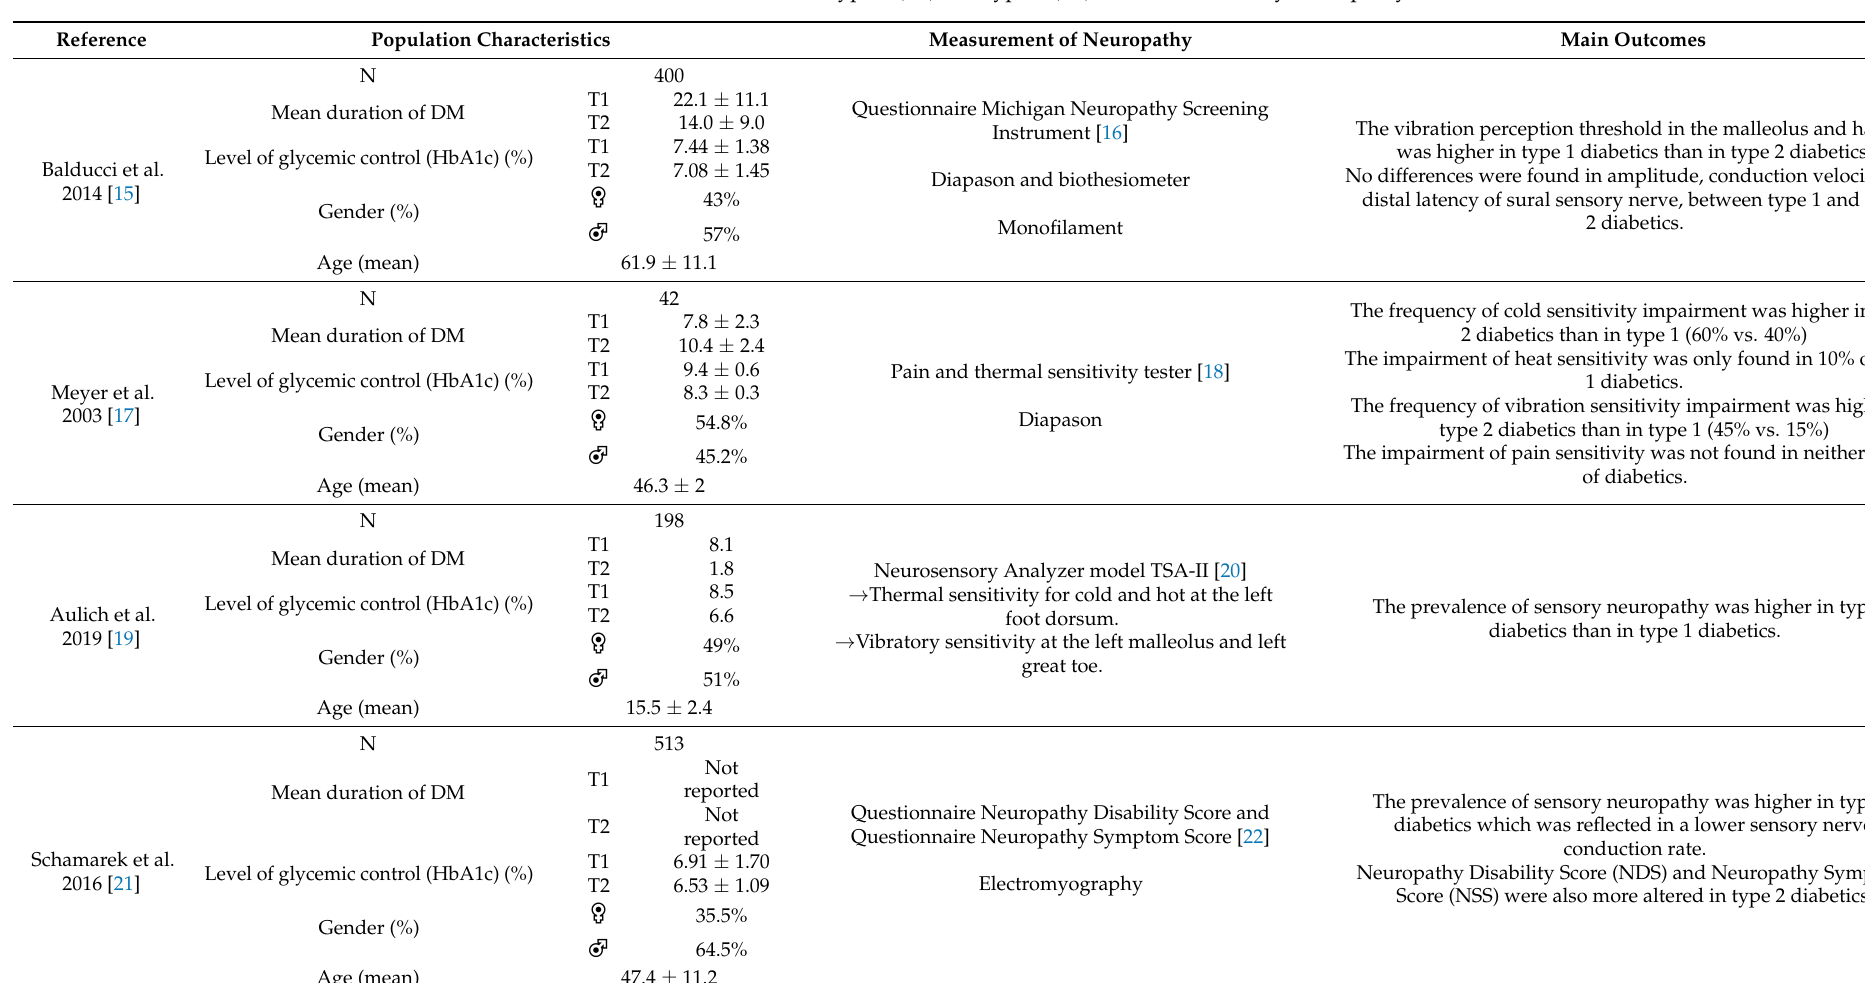
Table 1. Differences between type 1 (T1) and type 2 (T2) diabetes in sensory neuropathy. Figure 1. Systematic review workflow.